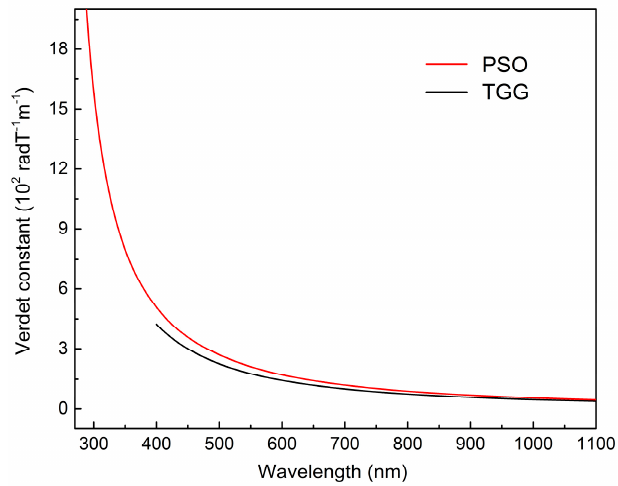
Figure 5. Verdet constant of as-grown PSO crystal vs. wavelength λ . TGG was tested as reference, and the experimental data were fitted by an equation A /( λ 2 − λ 02 ), with λ 0 and A constants.